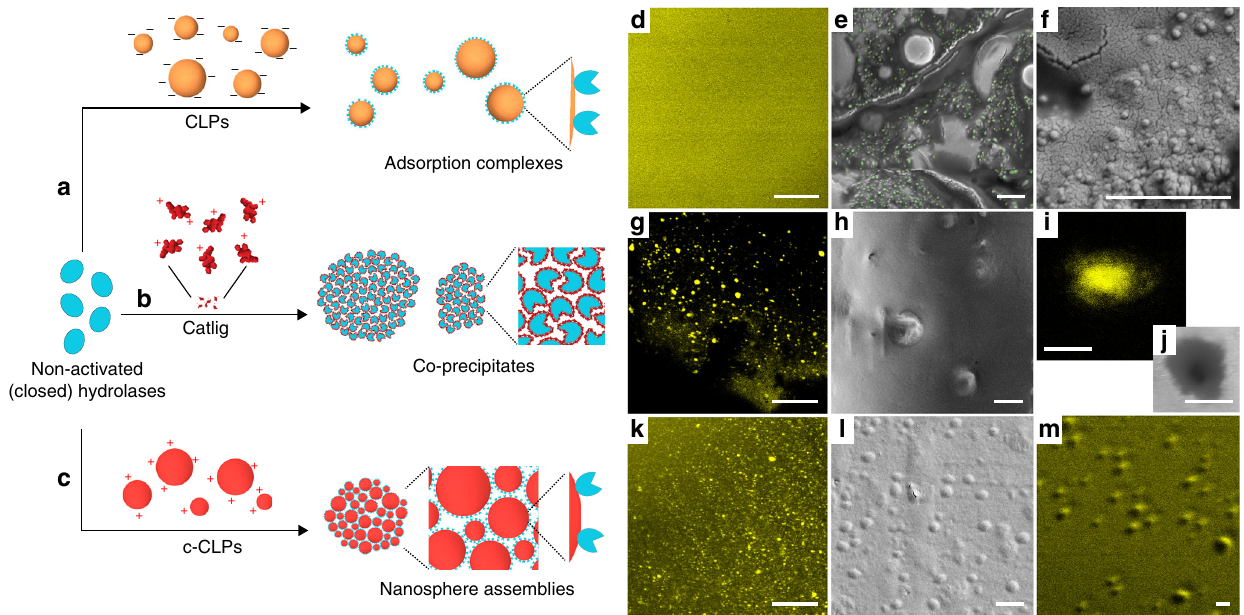
Fig. 3 Models and microscopic images of immobilized hydrolases. a Adsorption of hydrolases on colloidal lignin particles (CLPs). b Formation of precipitates from enzymes and cationic lignin (Catlig). c Enzyme adsorption on cationic lignin nanospheres (c-CLPs), and formation of spherical clusters from enzyme-c-CLP complexes. CLSM images ( d , g , i , k , m ) associated with the materials in rows ( a ‒ c ) show distribution of protein on acridine orange- stained cross-sections. SEM images show distribution of CLPs ( e with green coloring, f ), Catlig-Lipase M precipitates ( h , j ), and clustered c-CLPs and Lipase M ( l ). Scale bars: d , g , k = 40 µ m, rest = 1 µ m